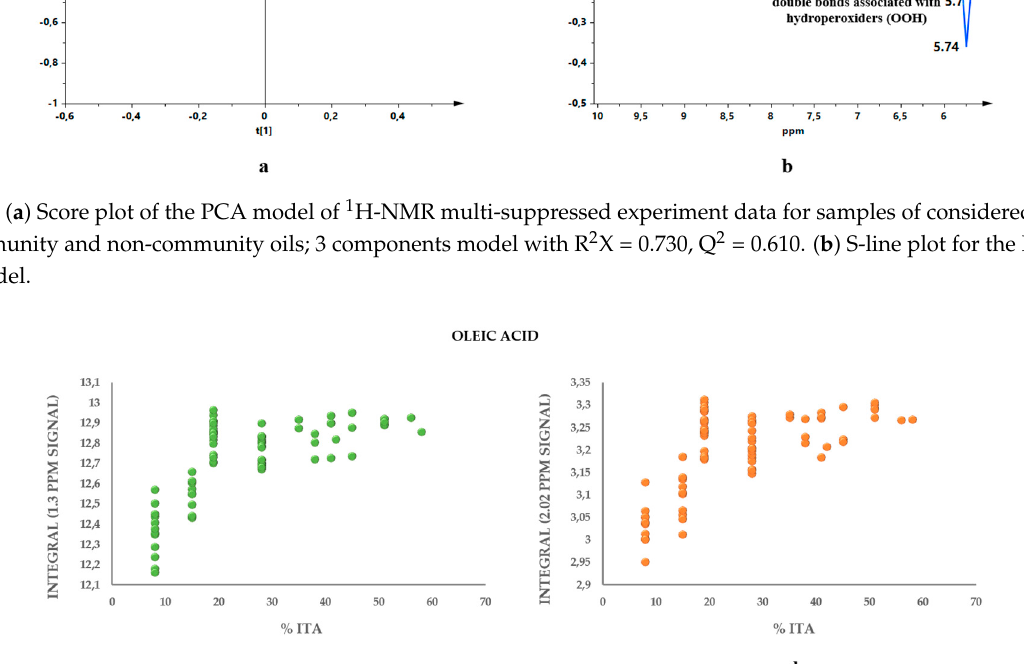
Figure 7. Quantification of oleic acid content correlated with the Italian component in the blends. Figure 8. Integral of the area underlying the peaks corresponding to polyphenols in the NMR spectrum—tyrosol, hydroxytyrosol and their derivatives ( a ) 6.78 ppm, oleocanthal, oleacein, oleuropein and ligstroside aglycon dialdehyde forms ( b ) 9.22 ppm and, oleocanthal, oleacein and elenolic acid ( c ) 9.62 ppm—correlated with the Italian component in the blends.